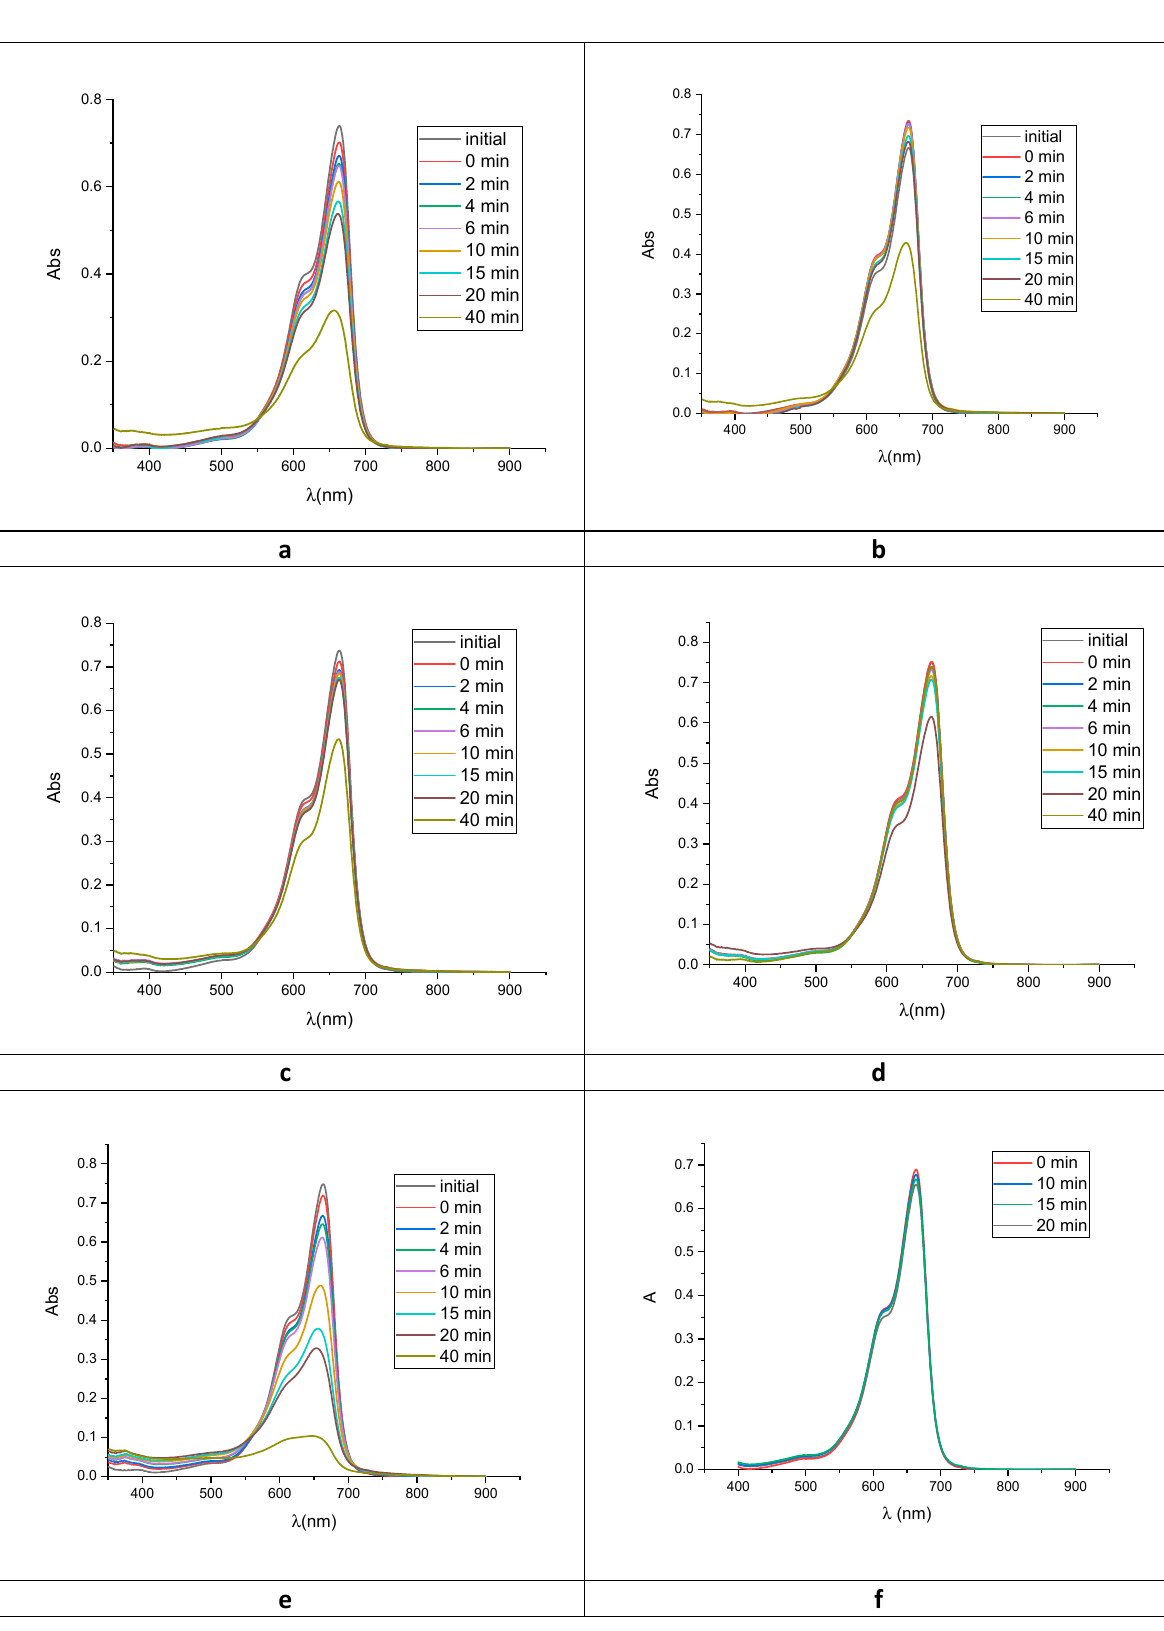
Figure 8. UV-vis spectra of methylene blue (MB) photodegradation under visible light (1.5 mg catalyst, 5 ppm MB) ( a ) ZnO_1, ( b ) ZnO_2, ( c ) ZnO_3, ( d ) ZnO_4, ( e ) ZnO (commercial 100 nm), ( f ) photolysis (without ZnO).